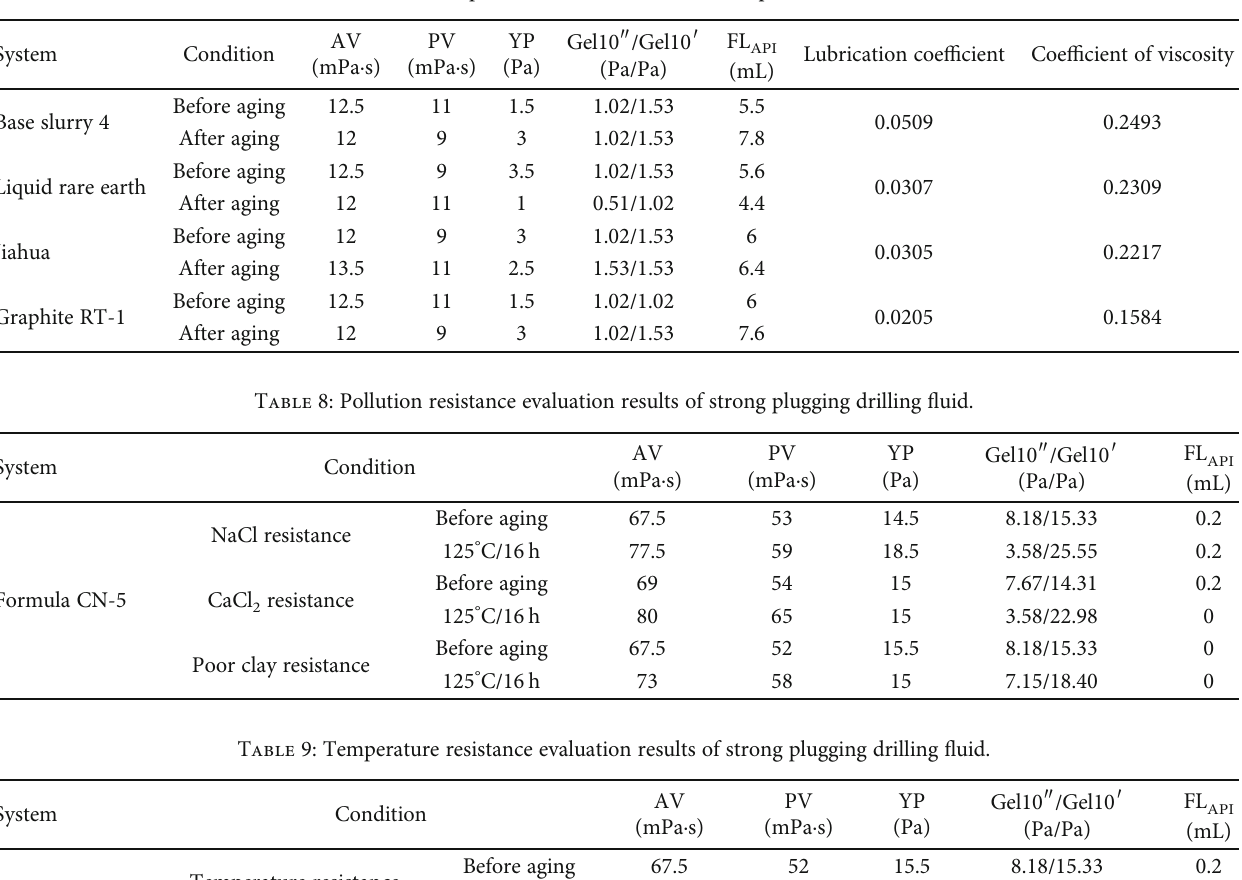
Table 7: Experimental results of lubricant optimization.